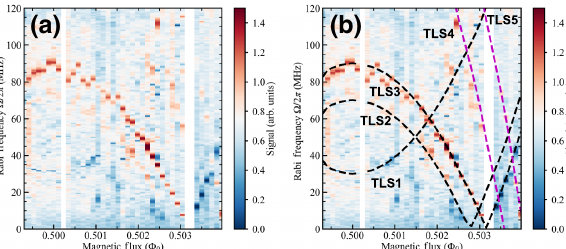
FIG. 14. Results of TLS defect spectroscopy in experiments with an applied in-plane magnetic field of 0.2 mT. The qubit is initialized in the | i −(cid:7) state in the rotating frame. (a) Excited-state qubit population as a function of the applied magnetic flux and the qubit drive amplitude in units of the Rabi frequency. (b) Com- parison of the experimental data obtained at 0.2 mT with the positions of spectral lines TLS1–TLS5 determined in the experi- ments at 0 mT. Dashed lines are plotted using the same equations and parameters as the dashed lines shown in Fig.